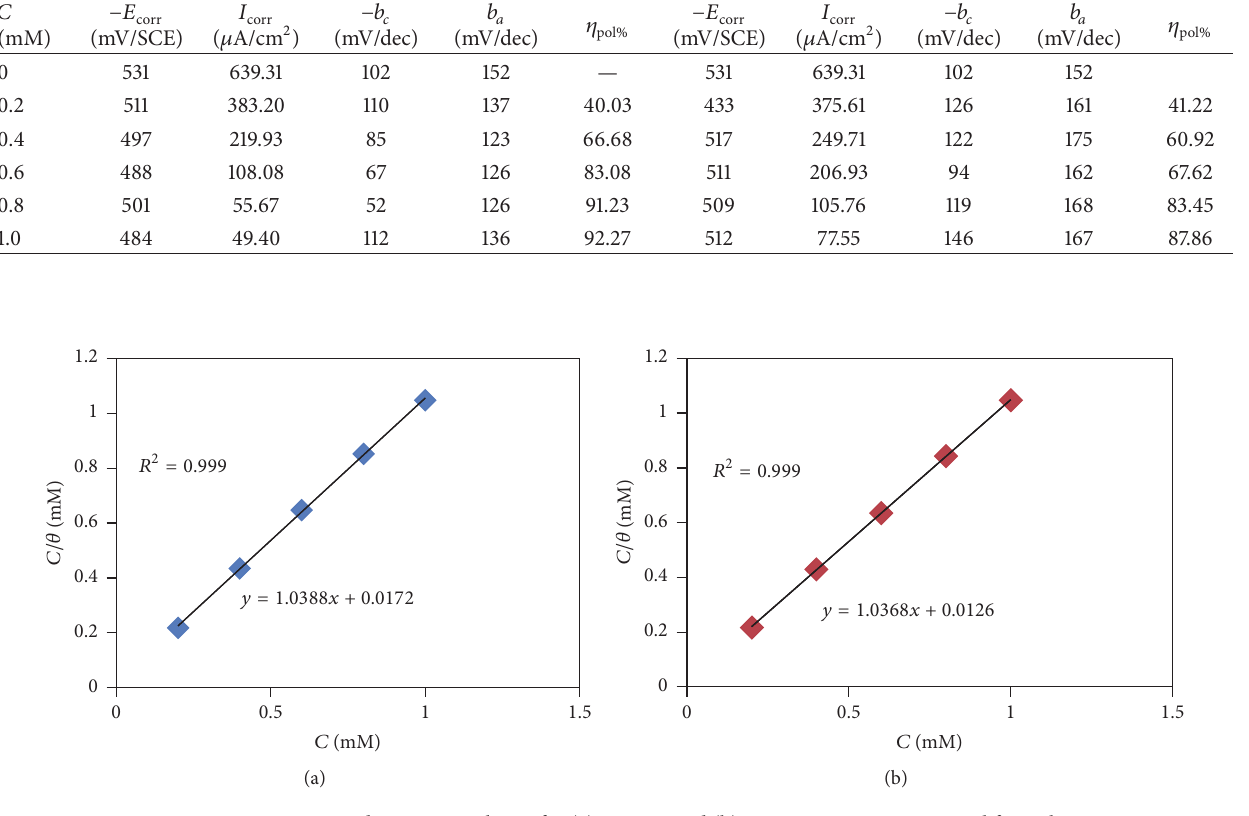
Figure 3: Langmuir adsorption isotherm for (a) P2APH and (b) RP2APH on CS in 1M HCl for 24 h.